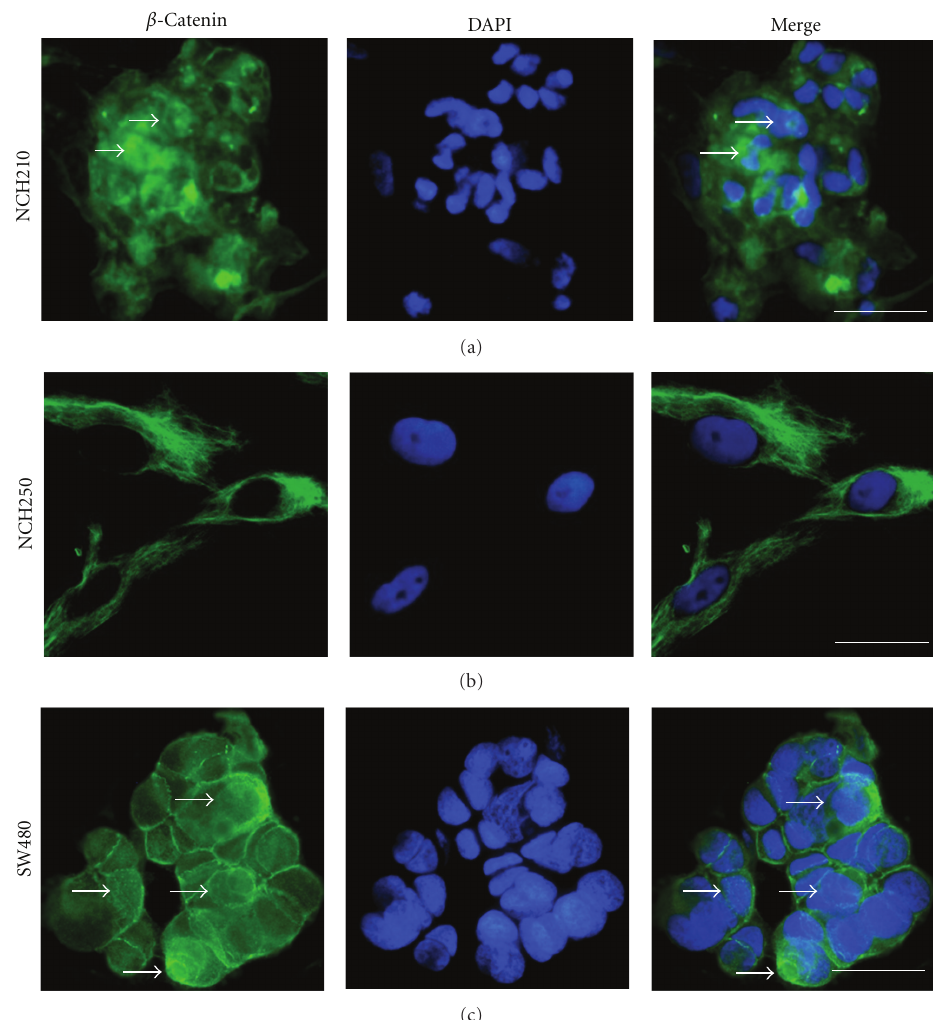
Figure 2: Immunofluorescent staining depicting β -catenin expression patterns in glioma cultures with no (NCH250 (b)) and moderately increased (NCH210 (a)) transcriptional activity and in the colon carcinoma cell line SW480 (c) known for its pronounced transcriptional activity. A preponderance of cytoplasmic and membranous rather than nuclear localization of β -catenin was confirmed in all cell lines analyzed. However, nuclear β -catenin levels (closed arrows) as a prerequisite for transcriptional activation were detected in single cells in NCH210 (a) and were relatively higher in SW480 (c). Scale bars represent 100 μ m (a) and 50 μ m (b and c), respectively.